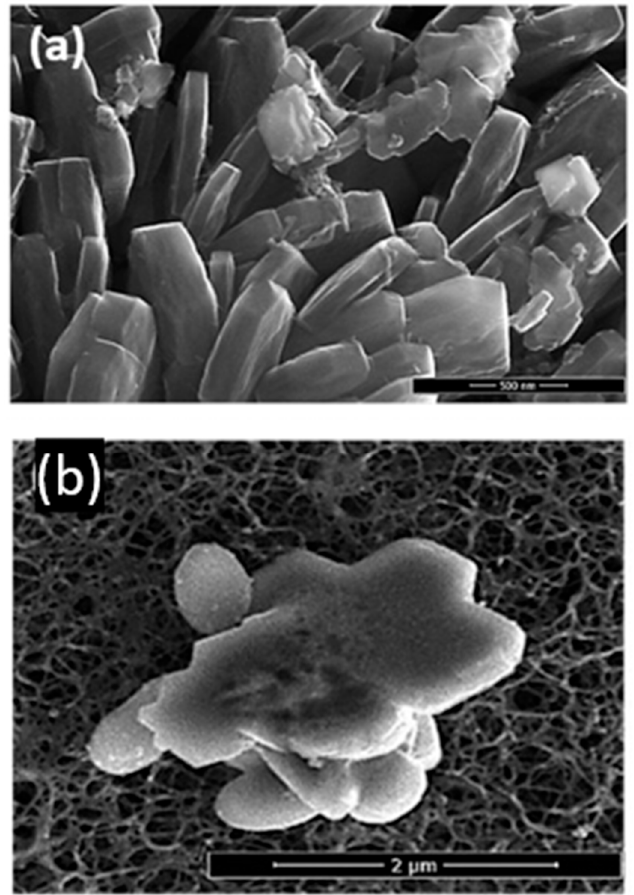
Figure 2. SEM images of ( a ) aggregated disk-shaped Al NPs obtained from a commercial Al foil; ( b ) E. coli bacterial cells attached to Al NPs (Adapted from Kunz et al. [29]).